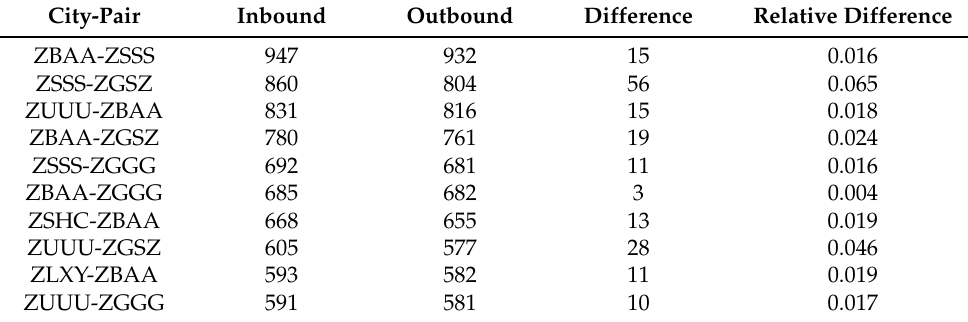
Table 4. The top ten city-pairs in the flight schedule in June 2017.